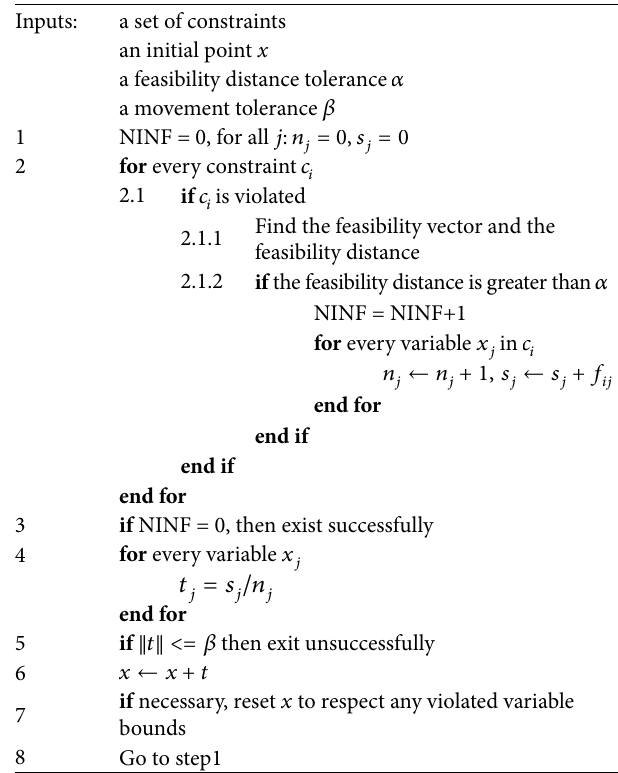
Table 3: Constraint consensus